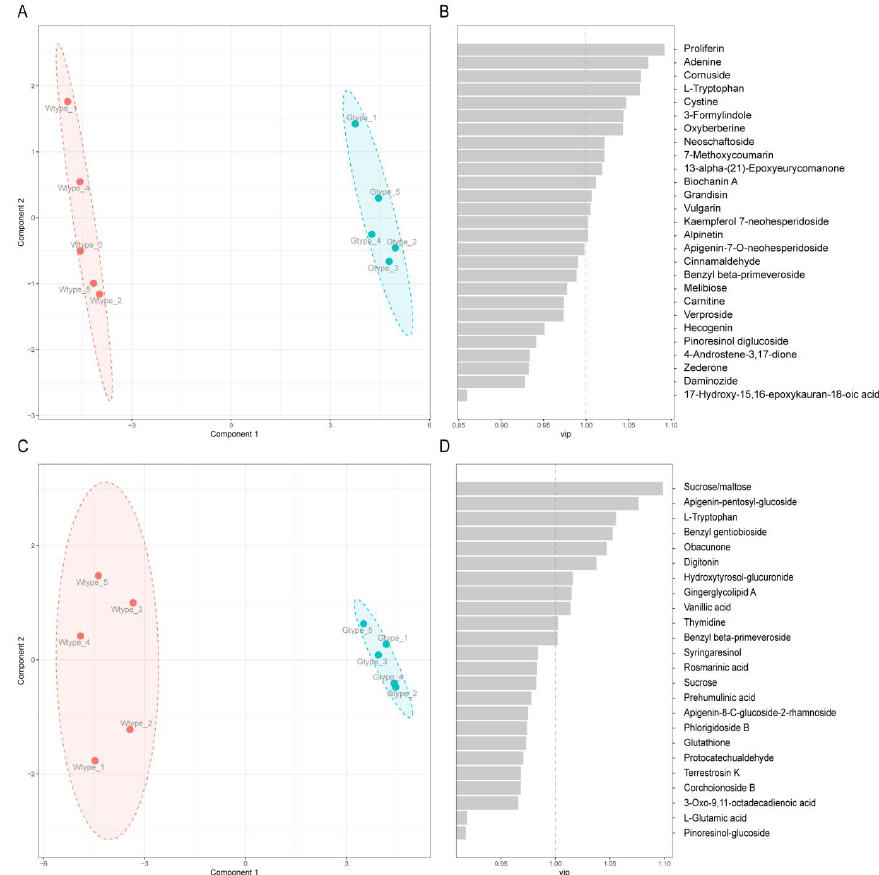
Figure 5. PLS-DA scatter plot ( A ) of the 27 differentially altered metabolites that were identified in positive ionization mode and their corresponding VIP values ( B ). PLS-DA scatter plot ( C ) of 24 dif- ferentially altered metabolites that were identified in negative ionization mode and their corre- sponding VIP values ( D ). 2.4. Comparison of the Differentiating Phenolic Compounds, Terpenoids, and Alkaloids The comparison of the peak areas of the differentiating twelve phenolic compounds, five terpenoids, and two alkaloids is demonstrated in Figure 6. In specific, four metabo- lites, including oxyberberine, proliferin, alpinetin, and grandisin, showed higher abun- dance in Gtype samples (Figure 6A). As shown in Figure 6A, approximately 24 times higher amounts of oxyberberine were detected in Gtype P. sibiricum samples under the